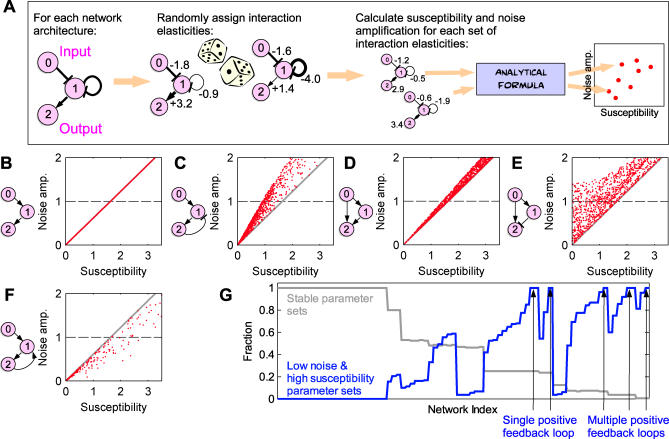
Screen for Networks with High Susceptibility and Low Noise Amplification(A) Each network with an input node 0, an output node 2, and an intermediate node 1 was assigned random sets of interaction elasticities. The susceptibility and noise amplification were calculated from each elasticity set. Results are shown for (B) linear cascade (1,000 points), (C) two-node negative feedback (1,000 points), (D) coherent FFL (1,000 points), (E) incoherent FFL (1,000 points), and (F) two-node positive feedback (230 points with a stable steady state).(G) All networks were sorted into groups according to the fraction of parameter sets that exhibited stability (gray line). Within each group, the networks were sorted according to the fraction of low noise and high susceptibility parameter sets (relative to a linear cascade) out of the stable sets (blue line). As the number of positive feedback loops increases, stability is decreased.